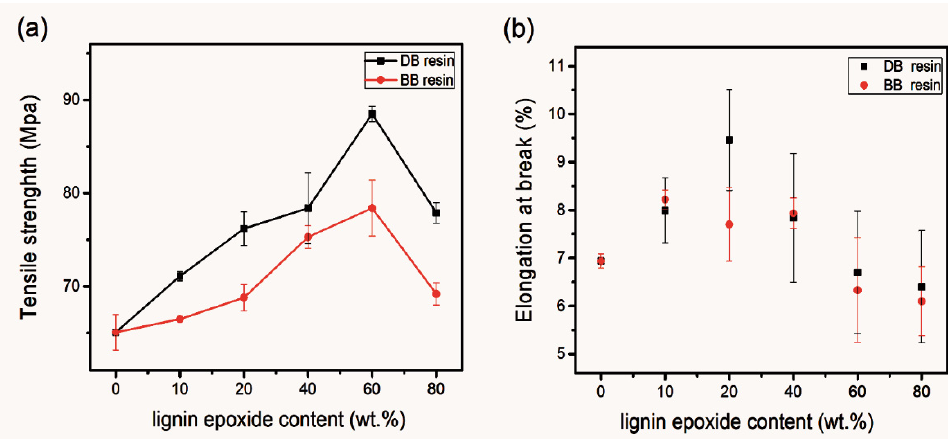
Figure 4. Tensile strength ( a ) and elongation at break ( b ) of the DMAP-lignin epoxide/BADGE (DB) and BTEAC-lignin epoxide/BADGE (BB) resins with the different weight percentages of lignin epoxide. The lignin epoxide content is the weight percentages of DMAP-lignin epoxide replacement of BADGE.